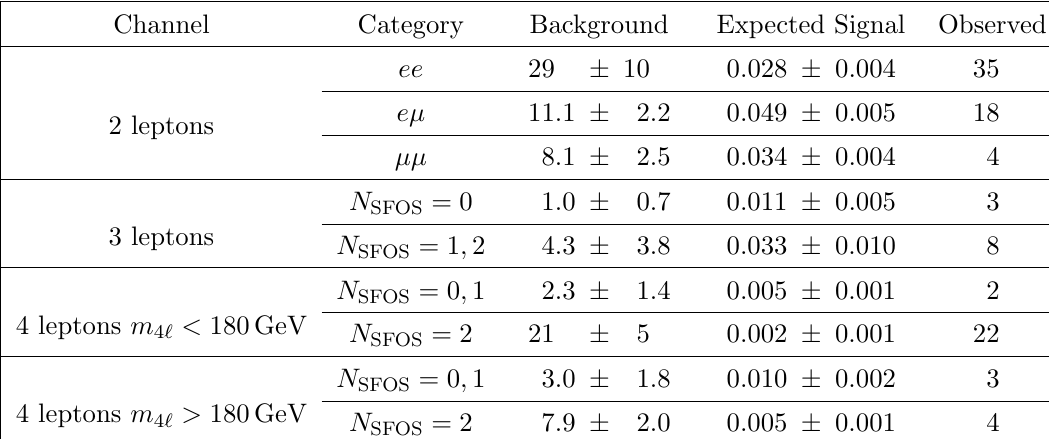
Table 1 . Expected and observed yields in each channel after all selection criteria and the pro(cid:12)le- likelihood (cid:12)t for the non-resonant HH production searches. The expected signal refers to the SM non-resonant HH production, corresponding to its calculated cross-section at 33.4 fb. The label N SFOS indicates the number of same-(cid:13)avour, opposite-sign lepton pairs in the channel. Systematic uncertainties on the signal and background estimates are